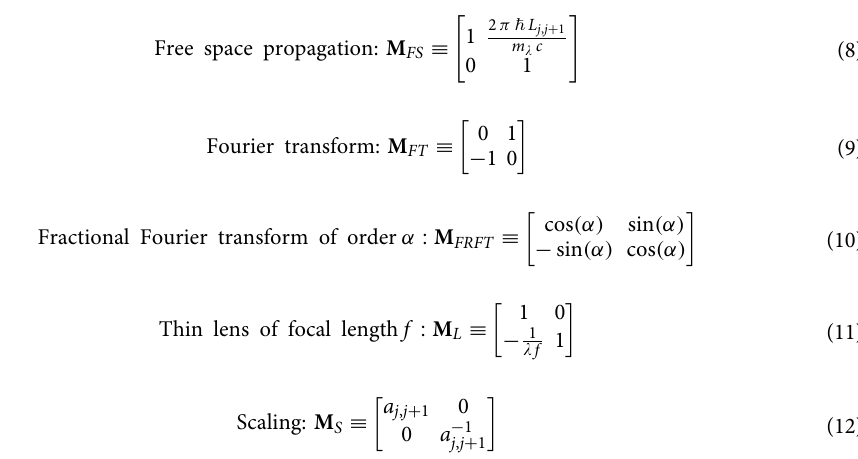
1 , and a single sensor plane on which exponentially + 1 is implemented with sections of FSP for the + 1 between +